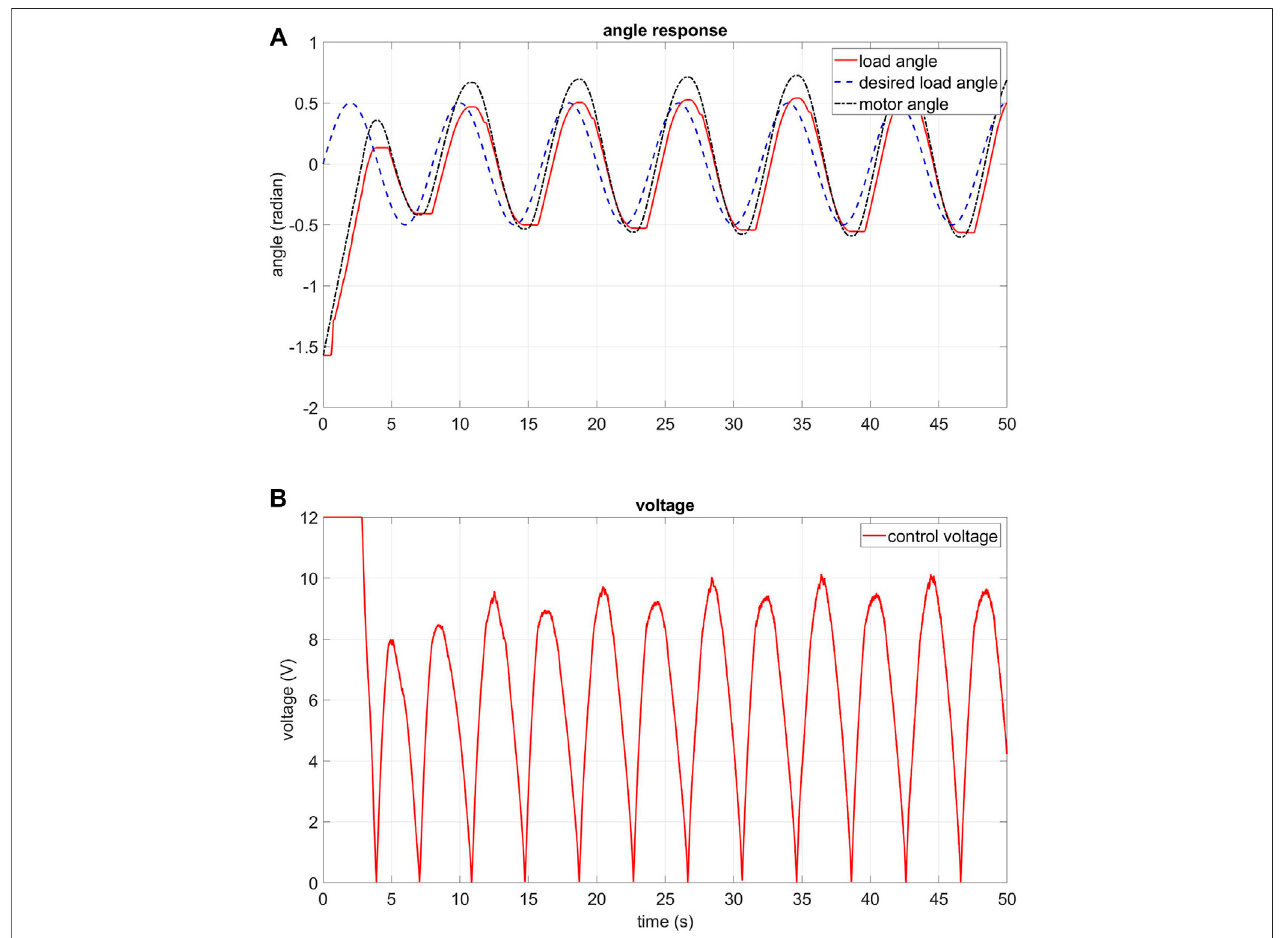
FIGURE15| Experiment:angleresponseandcontrolvoltageoftheFPIC-MRACofjoint1innormalcondition,sinewaveforminput (A) angleresponseofjoint1 (B) control voltage of joint 1.